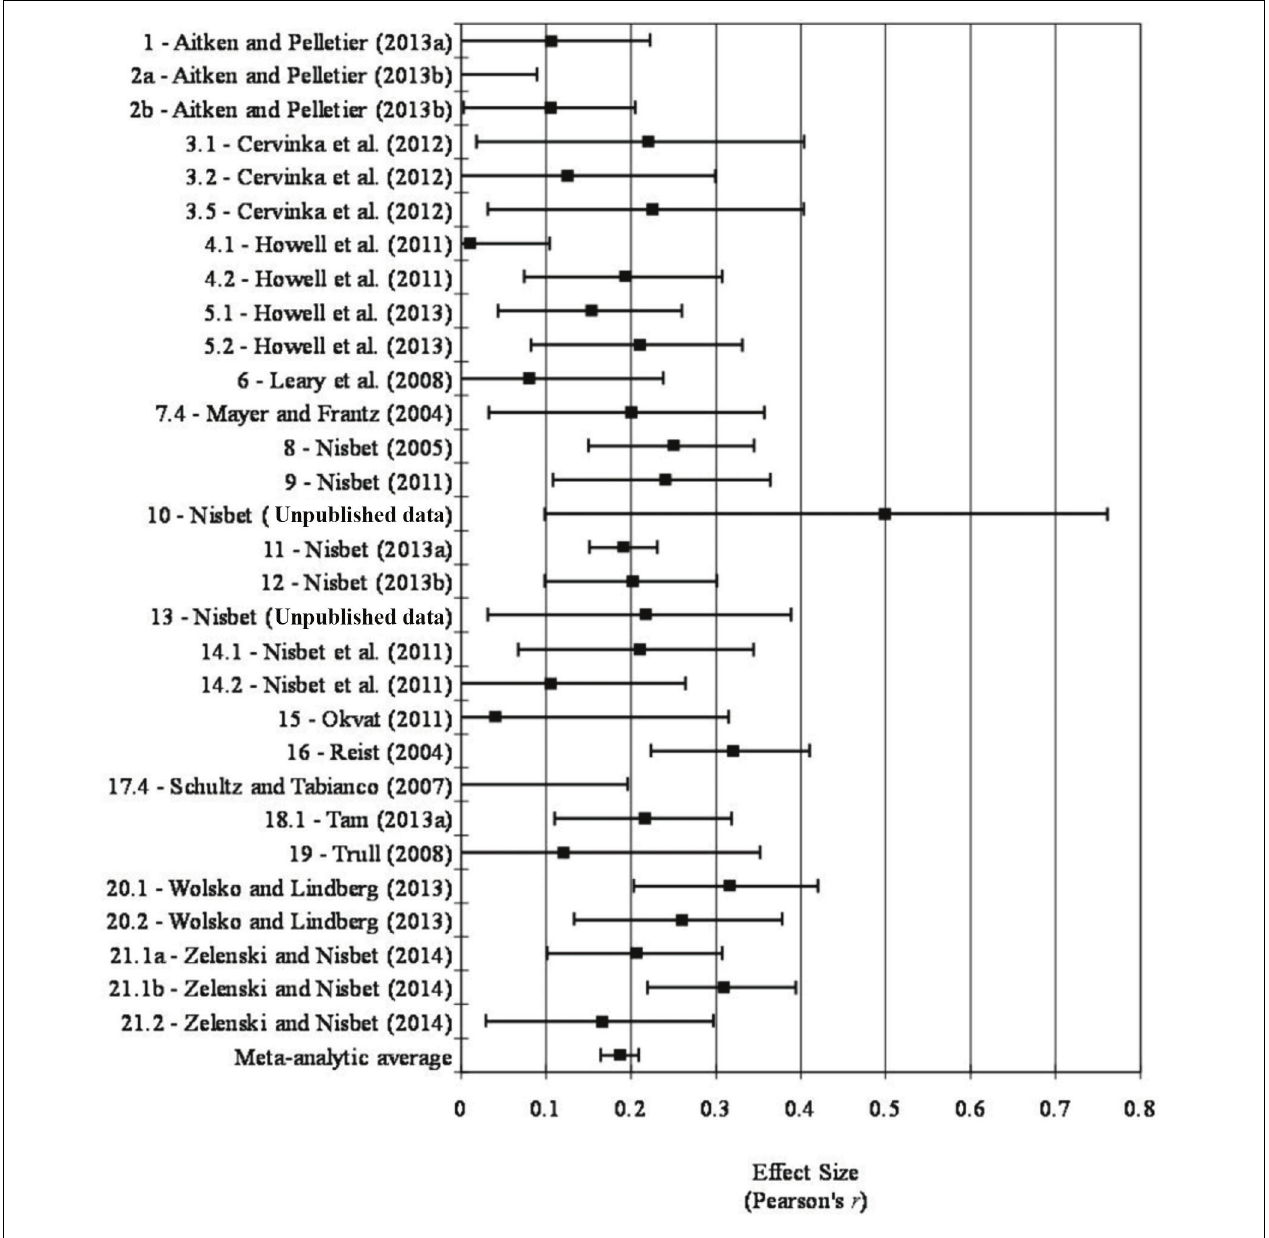
FIGURE 1 | Forest plot.